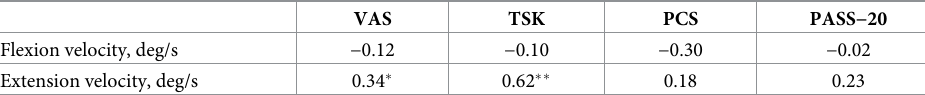
Table 4. The relationships between the kinematic data at the first trial and pain-related factors. VAS TSK PCS PASS − 20 Flexion velocity, deg/s − 0.12 − 0.10 − 0.30 − 0.02 Extension velocity, deg/s 0.34 � 0.62 �� 0.18 0.23 The data are r-values. VAS: pain intensity in the past 4 weeks. � p < 0.05 �� p < 0.01.